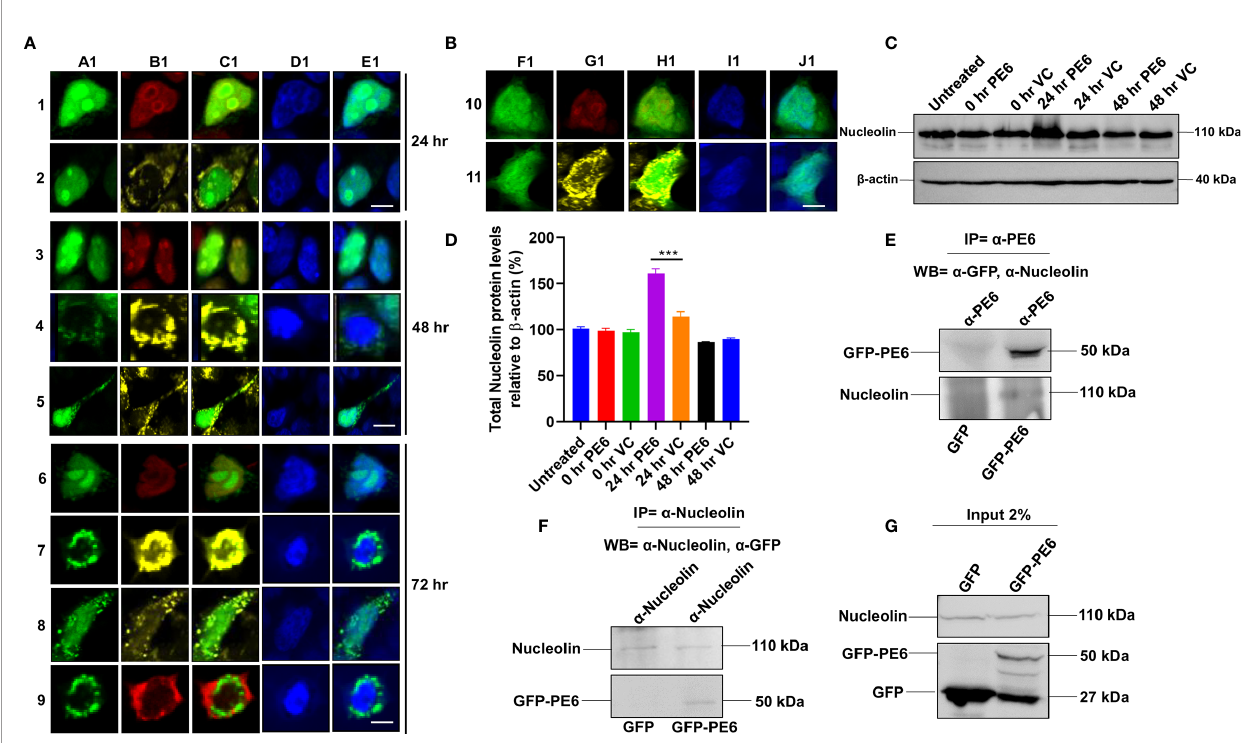
FIGURE 4 | M. tb PE6 targeted to nucleus/nucleolus and mitochondria in transiently transfected HEK293T cells interacts with Nucleolin. (A, B) Confocal laser scanning microscopic analysis of GFP and GFP-PE6 expressing HEK293T cells. Transiently transfected cells were fi xed using 4% formaldehyde and washed with cold PBS. GFP-PE6 (green) and GFP (green) localization was analyzed at 24, 48, and 72 h post-transfection. Nucleolus was stained using an anti-Nucleolin antibody (pseudo red). Mitotracker deep red FM was used to study the mitochondrial localization (pseudo yellow). DAPI was used to stain the nucleus (blue). A547 conjugated secondary antibody was used for signal generation. Scale bars indicate 10 µm. (C) Western blots showing the Nucleolin level in macrophage cells infected with recombinant M. smegmatis containing pe6 and vector. After 24 h of infection, cell lysate was prepared and fractionated on SDS-PAGE, and proteins were transferred onto the PVDF membrane. Nucleolin levels were analyzed using the anti-Nucleolin antibody. Untreated and vector alone transformed cells were used as controls. b -actin was used as a loading control. (D) Densitometric quantitation of Nucleolin bands was represented as a bar graph. Nucleolin level was normalized to respective b -actin bands and represented as [%] protein levels to b -actin. Data were analyzed by one-way ANOVA with Tukey ’ s multiple comparison post-test. Data are representative of three independent experiments. ***P < 0.001 vs . control. (E, F) Western blots showing Co-IP of PE6 and Nucleolin from cell extracts prepared from HEK293T cells expressing GFP and GFP-PE6 using anti-PE6 and anti-Nucleolin antibodies, respectively. Lysates prepared from HEK293T cells expressing GFP were used as a negative control. Antibodies used in Co-IP and the Western blots are marked in the fi gure. (G) Protein levels of Nucleolin, GFP-PE6, and GFP in 2% input used in Co-IP